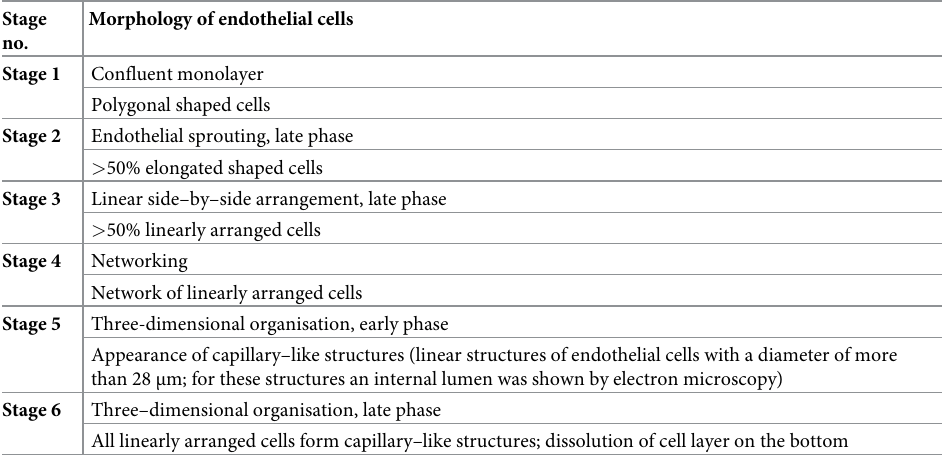
Table 1. Definition of stages of angiogenesis in vitro and description of cell morphology within the different stages [16]. Stage